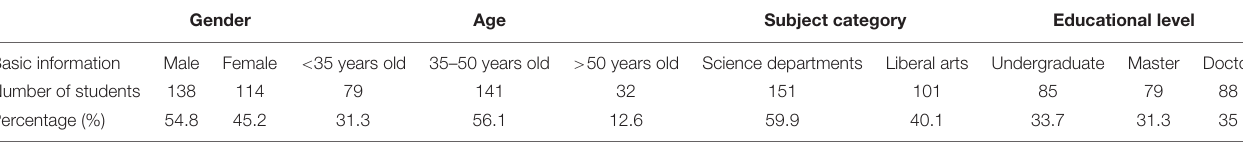
TABLE 1 | Statistics of demographic data of the investigated teaching staff. Gender Age